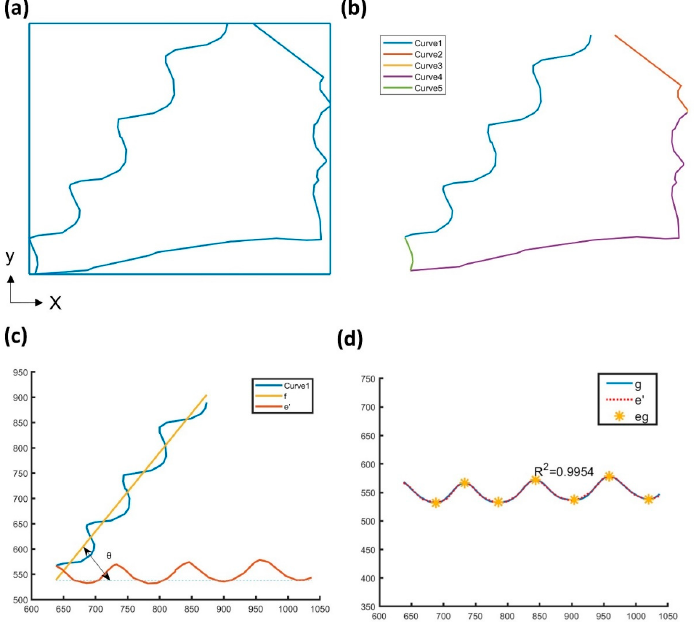
Figure 4. The characterization of fibers geometries by analyzing the helical-fibers of nonwoven sample: ( a ) edge detection; ( b ) dominant points edge detection; ( c ) the original Curve 1 and the rotated curve e’; ( d ) the Fourier fit curve and extreme points eg.